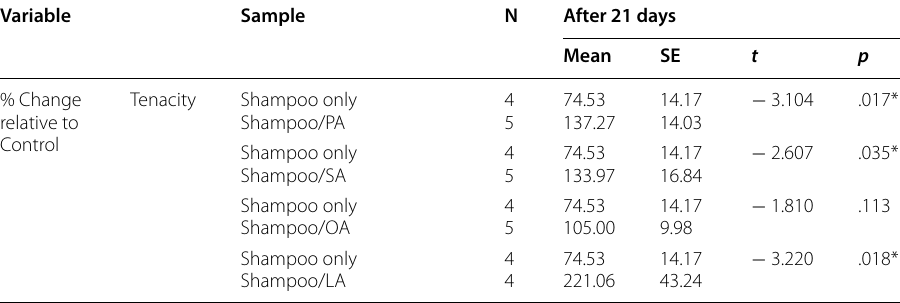
Table 15 t-test comparison of tensile strength and elongation after 21 days of treatment between BH shampooed only and BH shampooed with fatty acid conditioners Variable Sample N